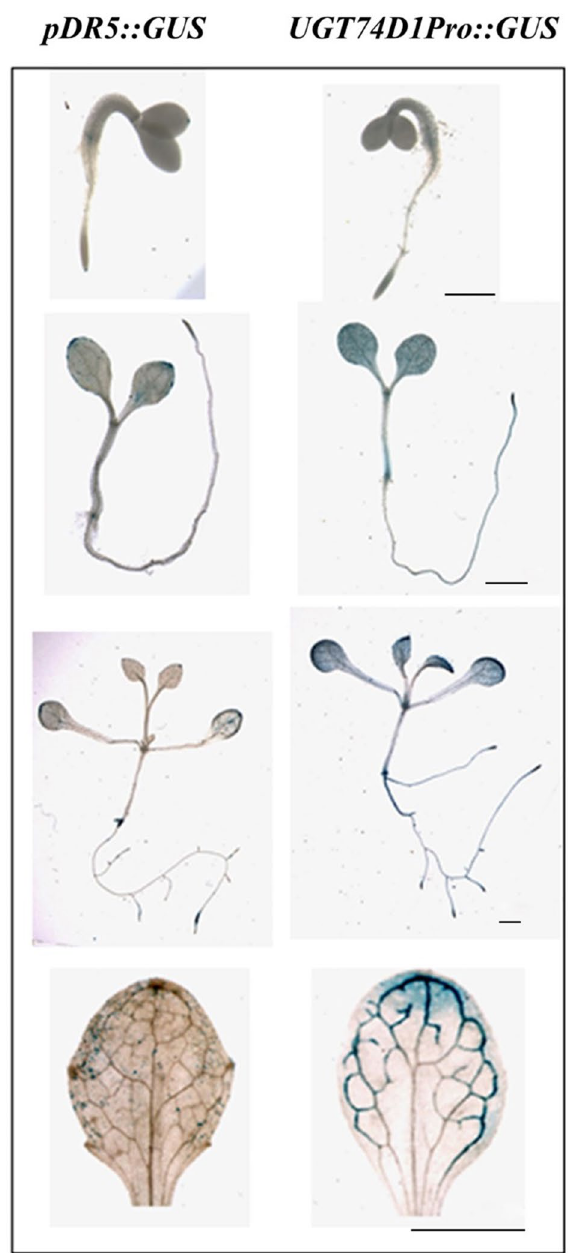
Figure 2. Localization of the auxin reporter pDR5::GUS activity and UGT74D1pro::GUS activity in cotyledon, hypocotyl, root, root apex, leaf and leaf edge. Scale bar = 1